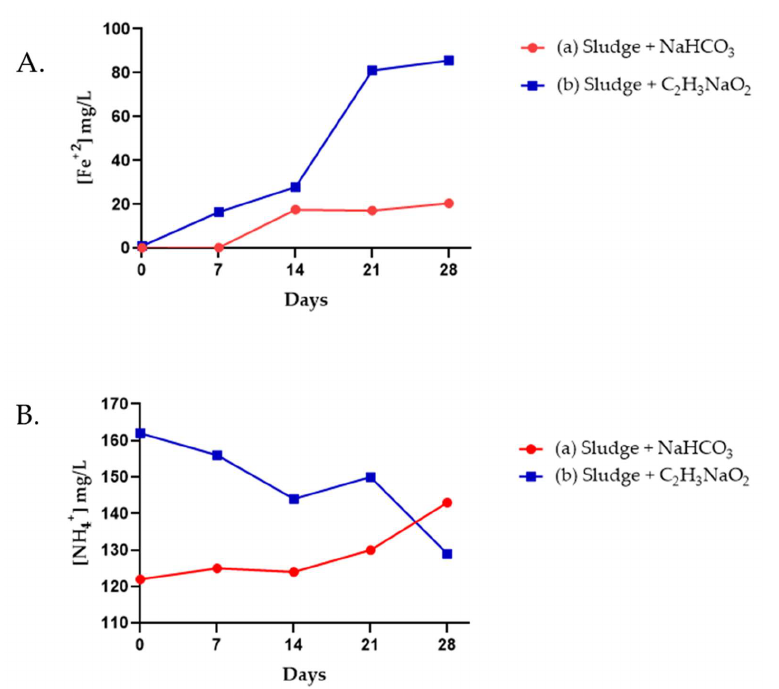
Figure 3. Concentration of Fe +2 ( A ) and NH 4 + ( B ) during enrichment process with IC sludge sample and using inorganic (NaHCO 3 ) and organic (C 2 H 3 NaO 2 ) carbon sources.